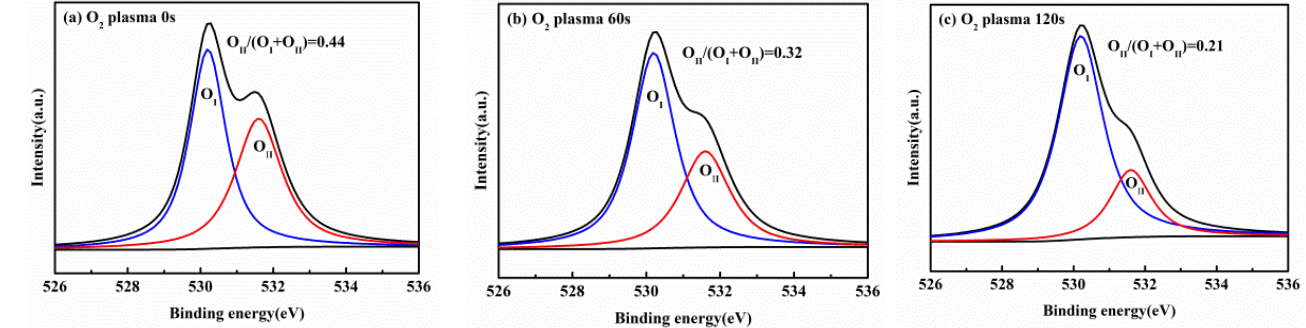
Figure 5. XPS spectra of a-IGZO thin films at the O 2 plasma times of ( a ) 0, ( b ) 60, and ( c ) 120 s. 50 nm thick Mo/100 nm thick TEOS oxide/40 nm thick a-IGZO structure on silicon sub-